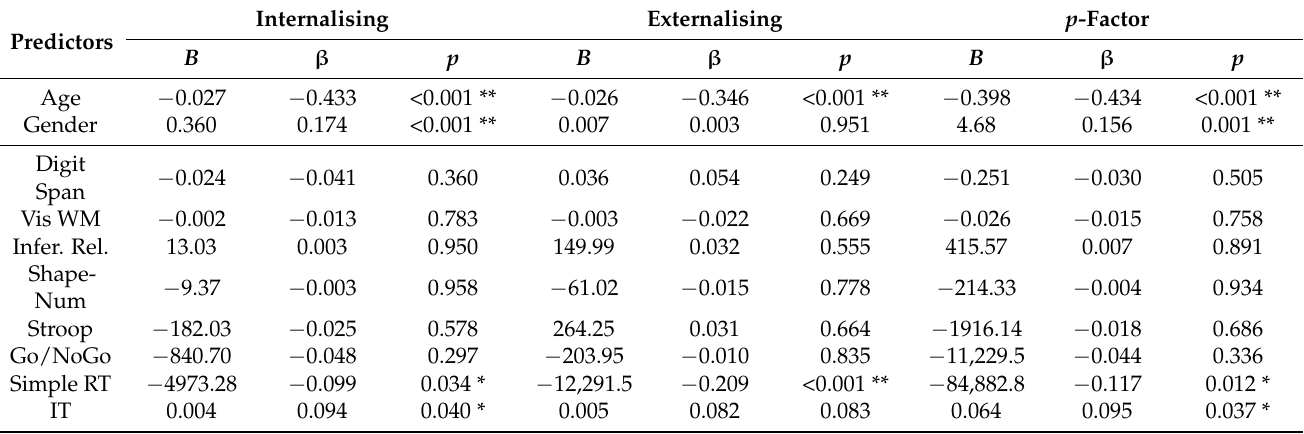
Table 2. Higher-Level Psychopathology Linear Model